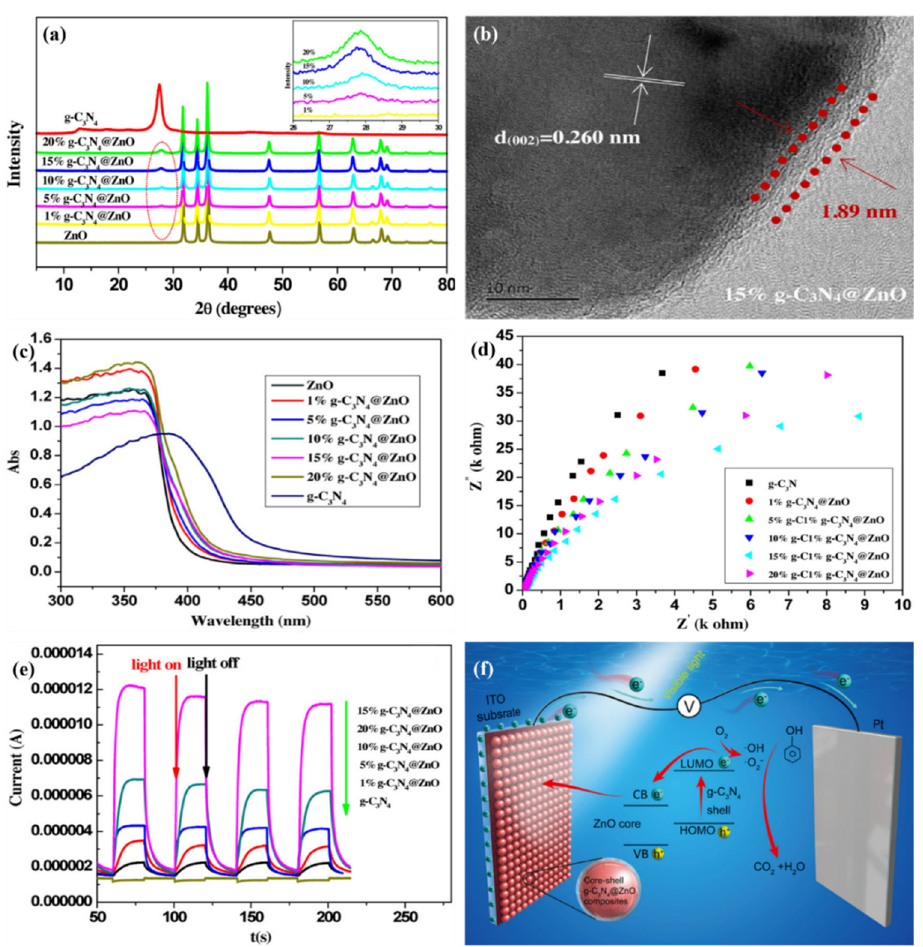
Figure 3. ( a ) XRD patterns, ( b ) HRTEM image of 15%CN@ZO material, ( c ) optical absorption spectra, ( d ) Nyquist plots, ( e ) I-t curves, and ( f ) charge transfer mechanism of the CN@ZO heterostructured electrode. Reprinted with permission from reference [60], Copyright 2017, Elsevier.